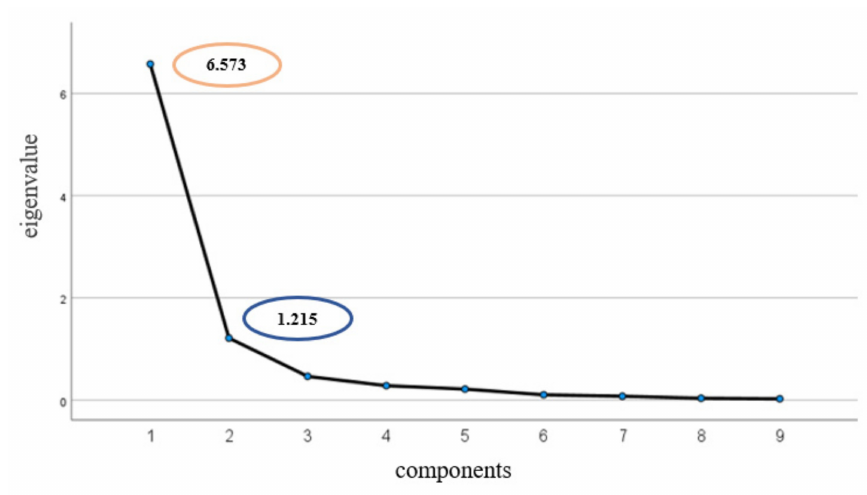
Figure 6. Principal component analysis: scree plot of the data collected from the Sele River and its estuary.